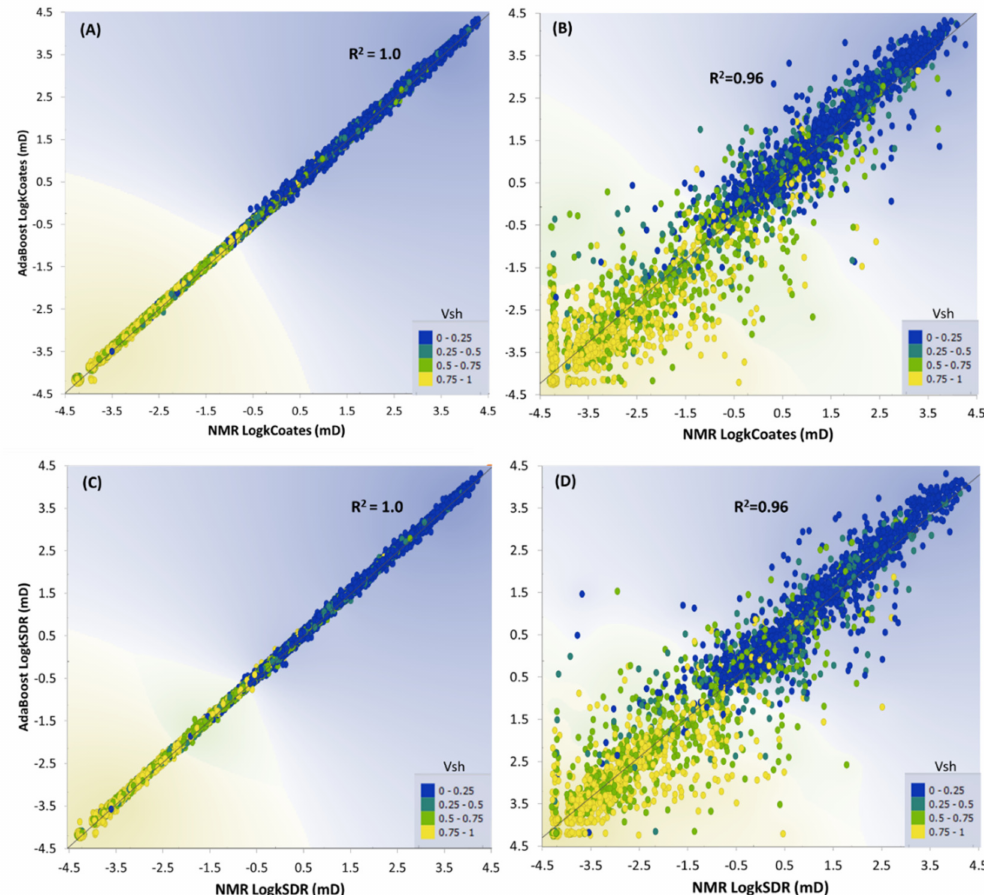
Figure 6. AdaBoost performance for prediction of Coates and SDR permeabilities in training ( A , C ) and blind ( B , D ) datasets, respectively.